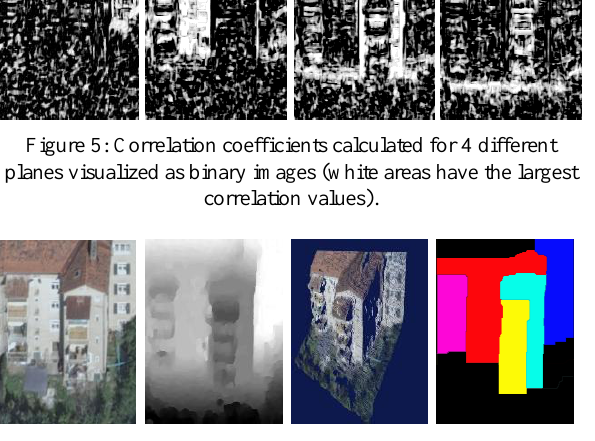
Figure 6: Reconstructed building facades using plane sweeping. (a) key view of facade (b) raw 3D point cloud (c) 3D point cloud overlaid with RGB information (d) segmentation of that point cloud into facade areas belonging to specific vertical planes.